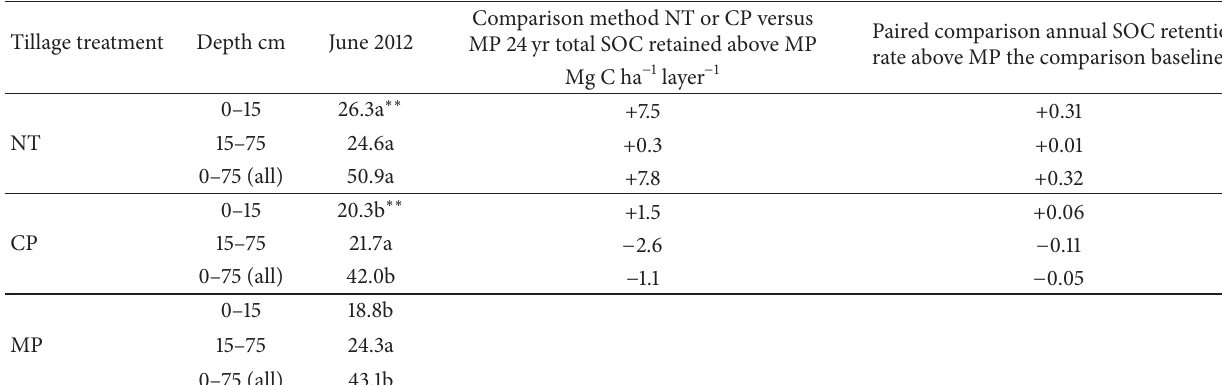
Table 5: Paired comparisons using MP as baseline to determine no-till (NT) and chisel plow (CP) effects after 24 years of tillage treatments on the volumetric SOC content change of the Grantsburg soil.